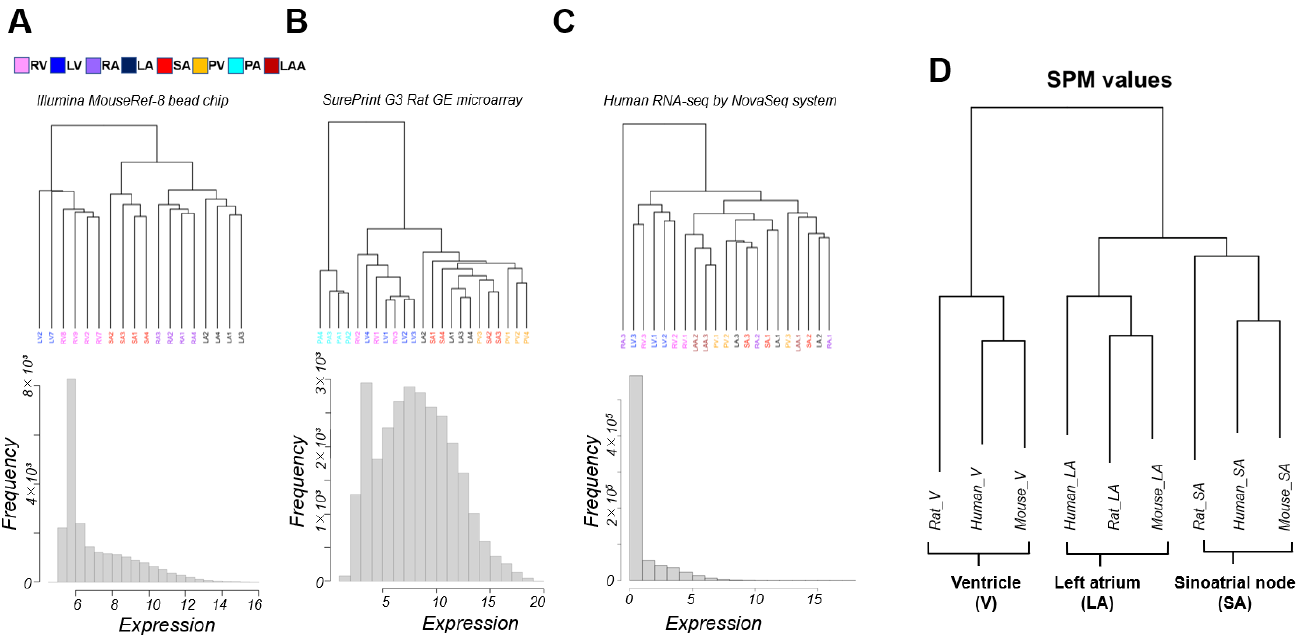
Figure 1. The clustering for the transcriptome samples and the distributions of expression intensity of gene expression intensities for mouse ( A ) and rat ( B ) array data (Illumina bead chip or SurePrint GE microarray) and ( C ) human RNA-seq data. ( D ) Interspecies comparisons of transcriptome data were performed using human gene ortholog relationships. For each gene, differences in expression levels between sites were tested by analysis of variance (ANOVA), and p values were calculated. For each gene, the site-specificity of the three sites was calculated as the specificity measure (SPM) value. Most of the analysis was performed on a single platform by SPM values. The results of hierarchical clustering of SPM values for site-specificity. Human genes with orthologs in mice and rats were targeted. The analysis was limited to the left atrium (LA), ventricles (V) (right ventricle (RV), and left ventricle (LV) data were combined), and sinoatrial nodes (SA), which are cardiac regions that are common in the transcriptome data. LAA; left atrial appendage, RA; right atrium, PA; pulmonary artery, PV; pulmonary vein. Each cardiopulmonary region is color-coded, with a corresponding panel in ( A ).